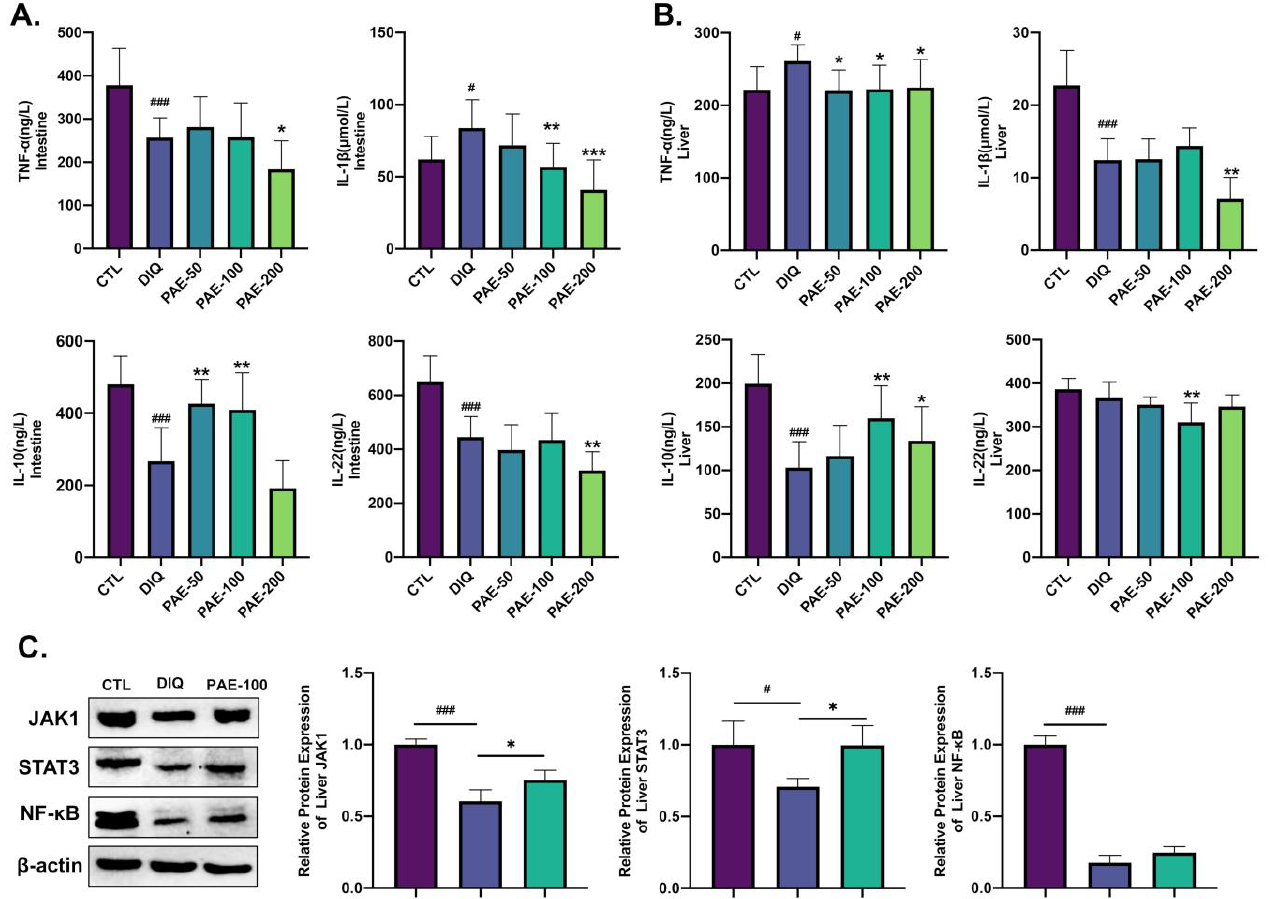
Figure 5. Effect of PAE on inflammation of the intestine and liver in diquat-treated mice: ( A ) Analysis of proinflammatory cytokines (TNF- α and IL-1 β ) and anti-inflammatory cytokines (IL-10 and IL-22) in the intestine ( n = 8); ( B ) analysis of proinflammatory cytokines (TNF- α and IL-1 β ) and anti- inflammatory cytokines (IL-10 and IL-22) in the liver ( n = 8); ( C ) analysis of the relative protein expression levels (JAK1, STAT3, and NF- κ B) in the liver ( n = 3). All data were represented as means ± SD. # p < 0.05, and ### p < 0.001 as compared with the control group; * p < 0.05, ** p < 0.01, and *** p < 0.001 as compared with the diquat group.